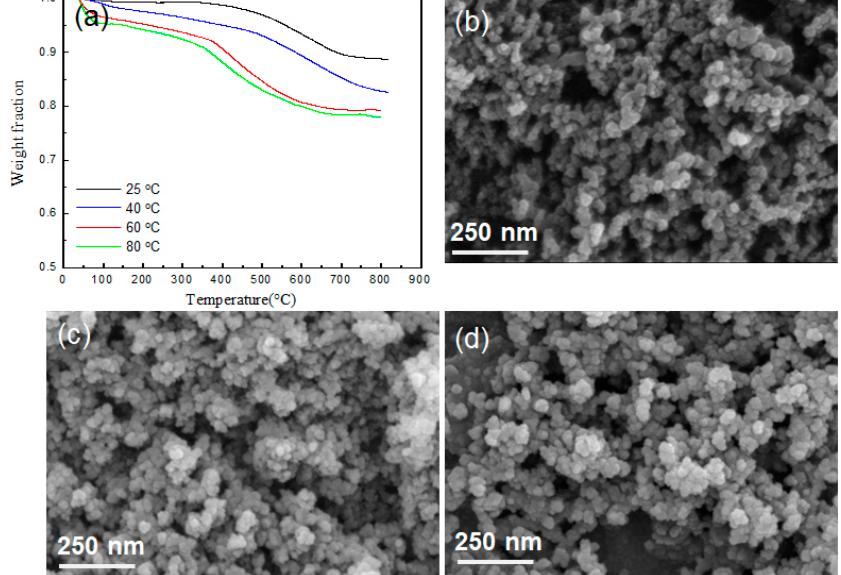
Figure 2. ( a ) TGA curves of pure silica aerogel and silica aerogels modified with APTES at different temperature and SEM images of pure silica aerogel ( b ) and silica aerogels modified with APTES ( c ) and PMDI ( d ).